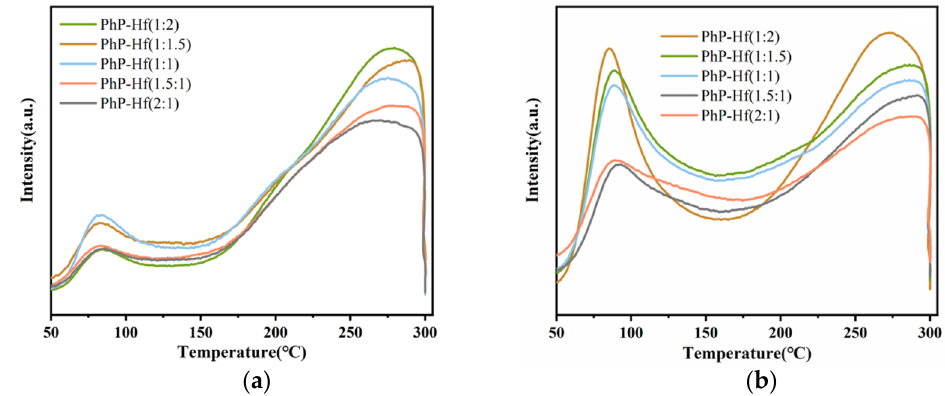
Figure 5. ( a ) CO 2 -TPD and ( b ) NH 3 -TPD patterns of different PhP-Hf catalysts. Table 2. Effect of different P/Hf ratios on the conversion of 4-MOPP to trans